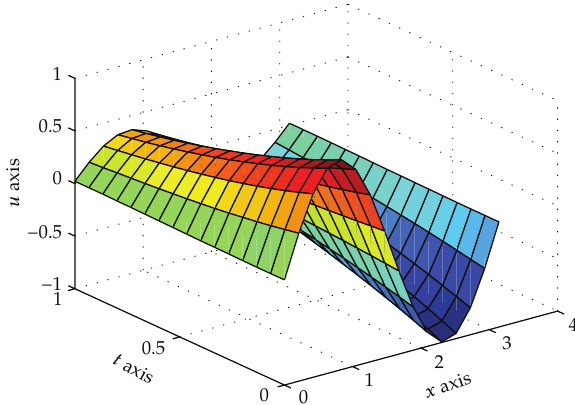
Figure 4: Numerical solution obtained by using the second-order di ff erence scheme (cid:4) 2.8 (cid:5)